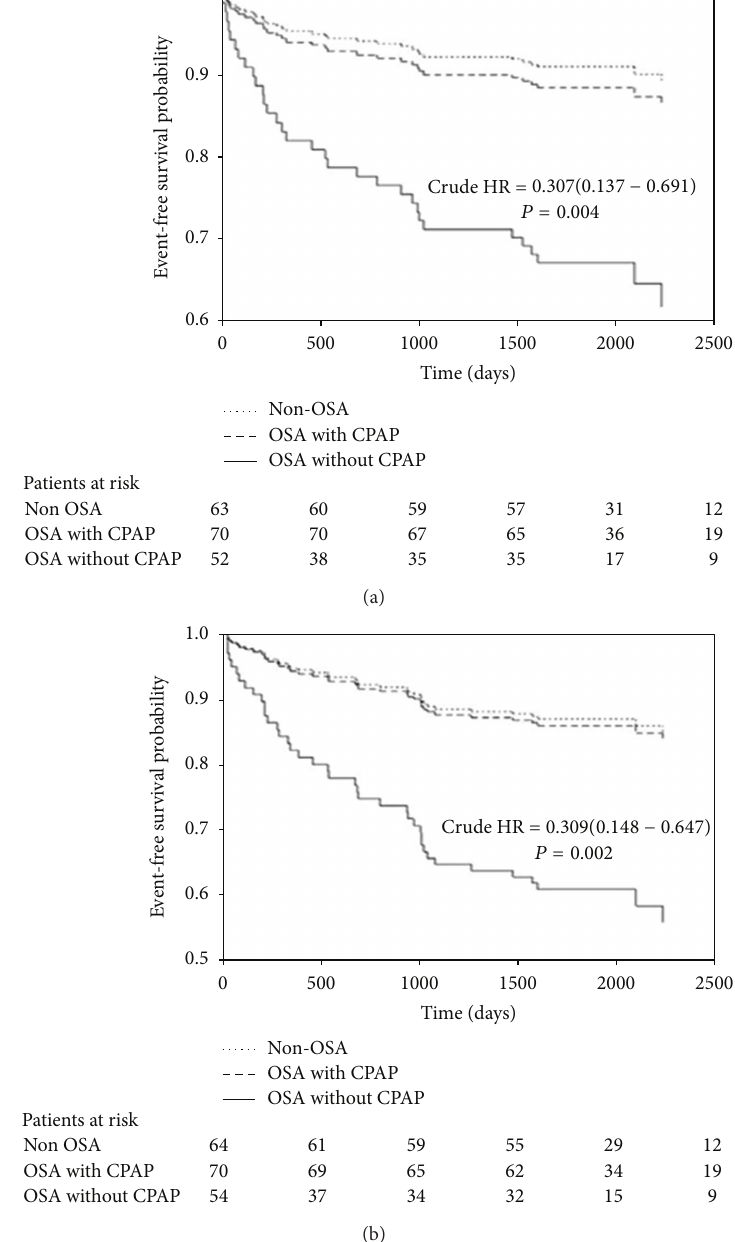
no difference in the number of MACE or MACCE between the 2